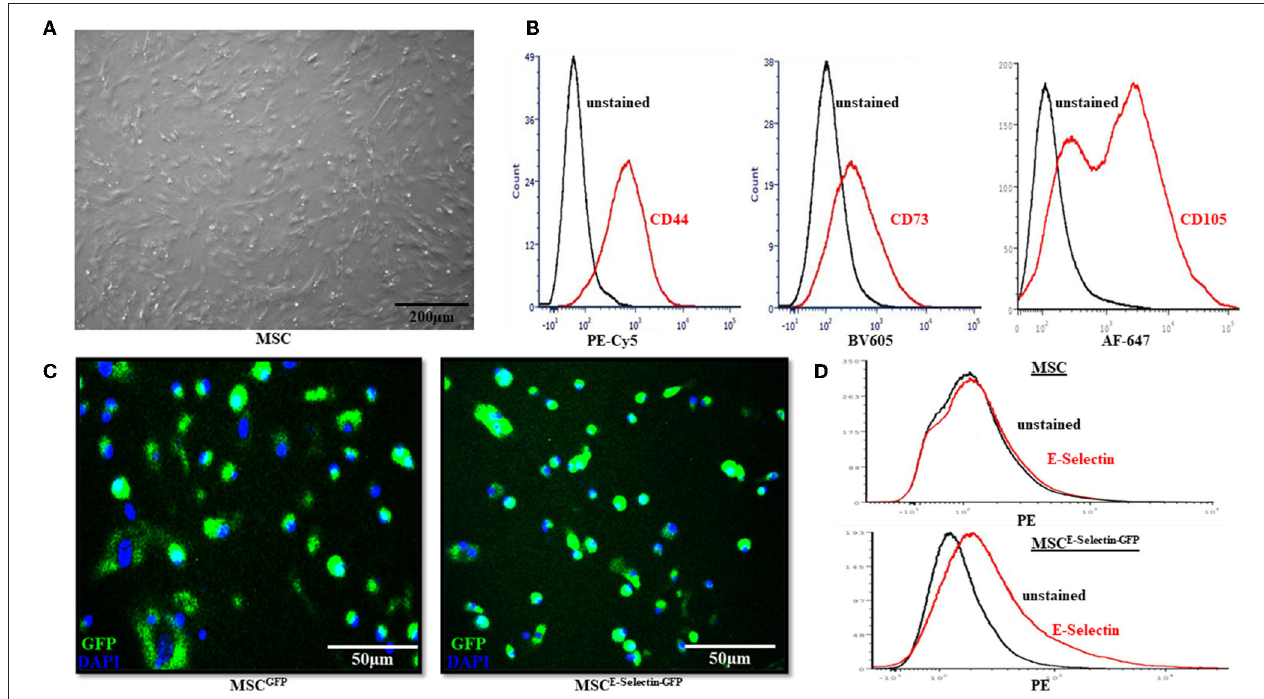
( Figure 1A ). Flow cytometry demonstrated positive expression of MSC markers CD44, CD73, and CD105 ( Figure 1B